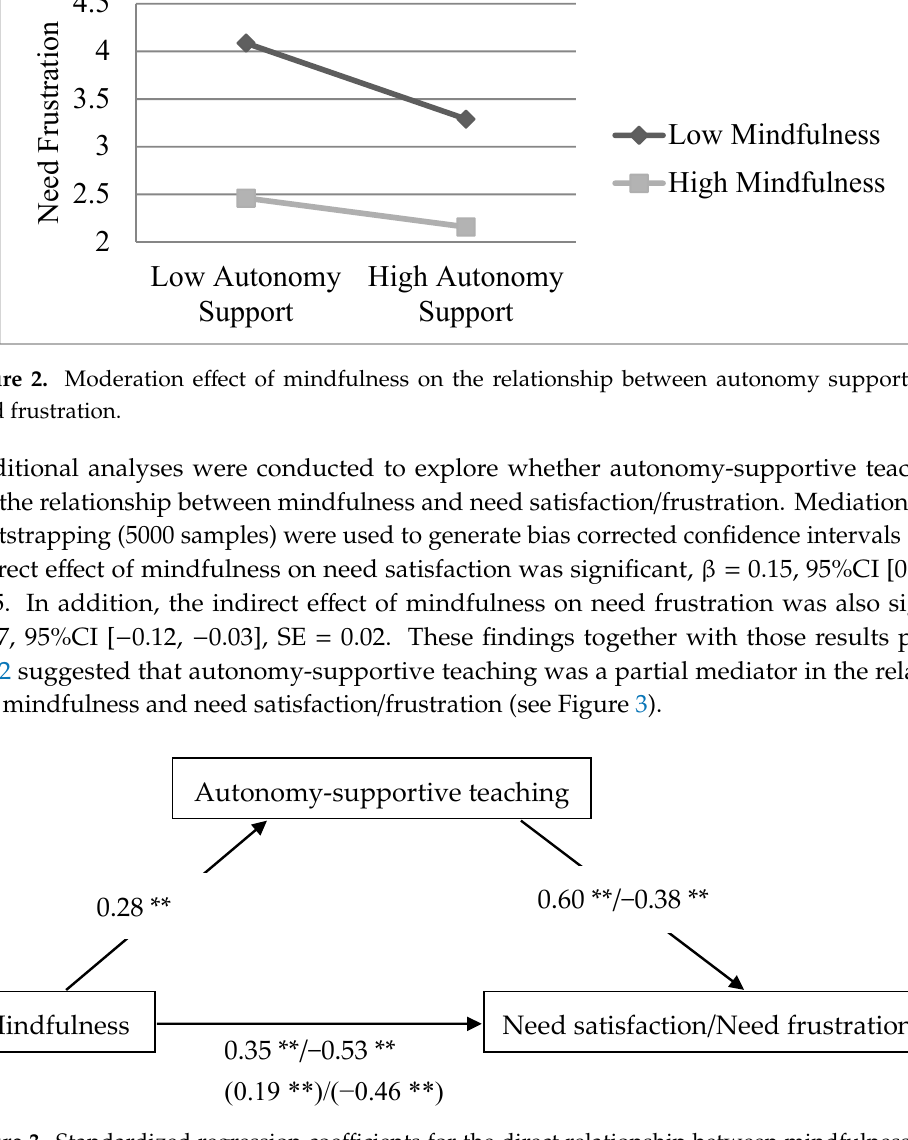
Figure 1. Moderation effect of mindfulness on the relationship between autonomy support and need satisfaction.